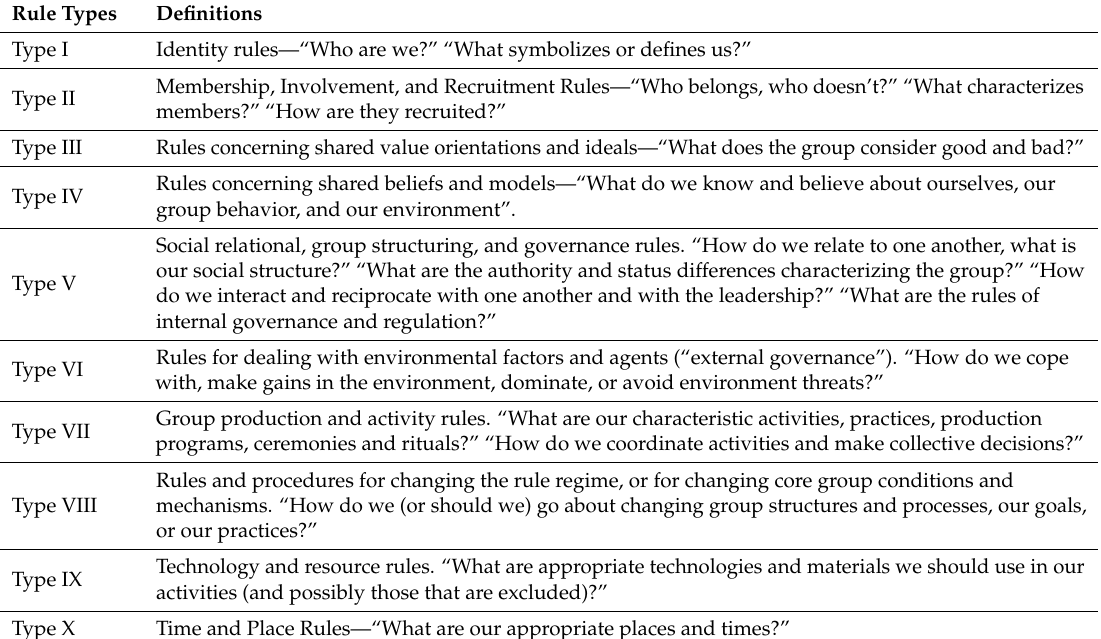
Table 1. Key Types of Rule Categories Specifying Group Conditions, Structures, and Processes.